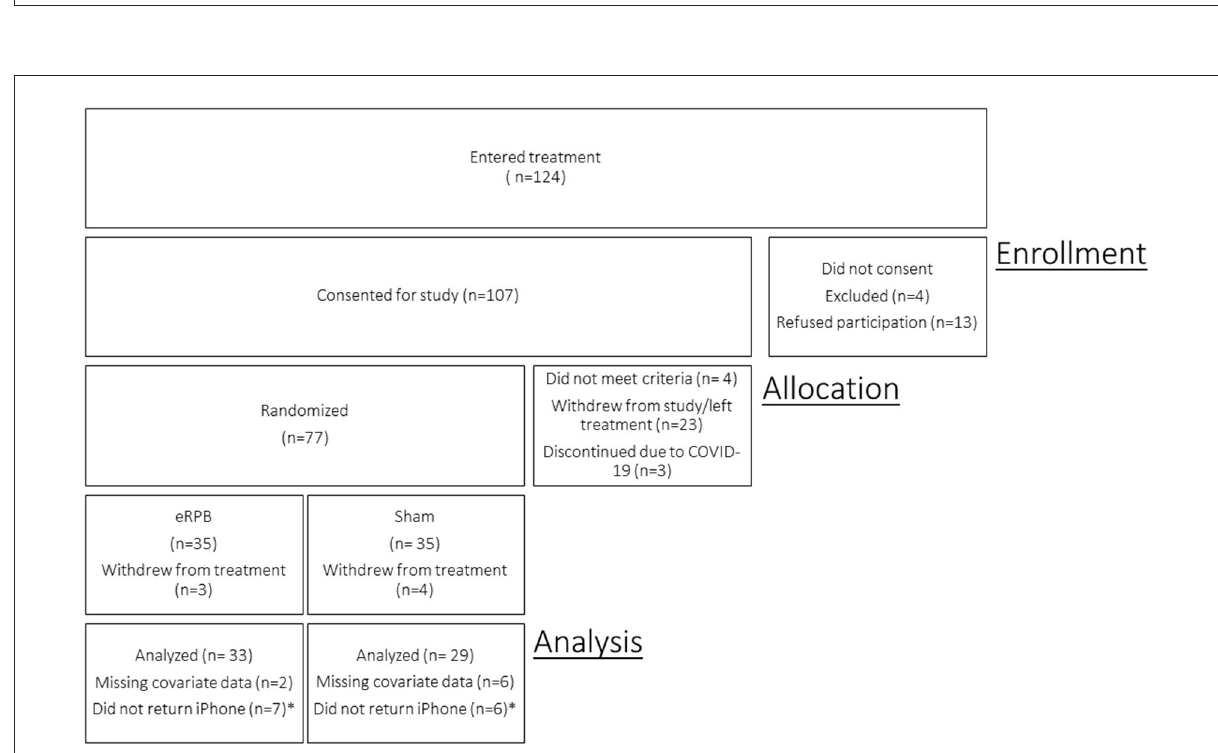
FIGURE2 CONSORT enrollment diagram. *Participants remained in the study and reported on usefulness of the intervention but did not return iPhone for app usage data download. Participants are included in model of Usefulness but not Use Frequency.